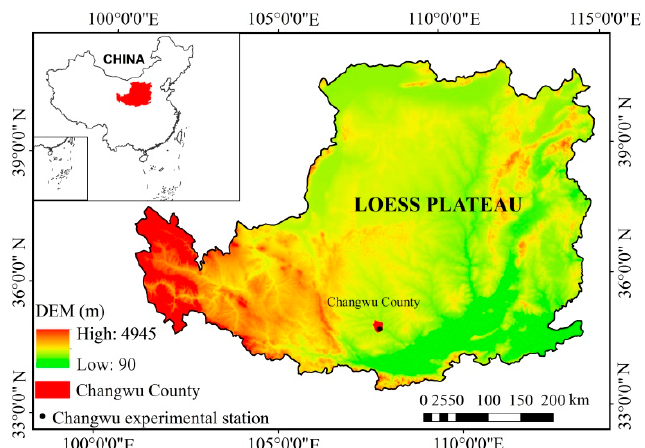
Figure 1. Location of the Loess Plateau and the Changwu Research Station of Agriculture and Ecology.